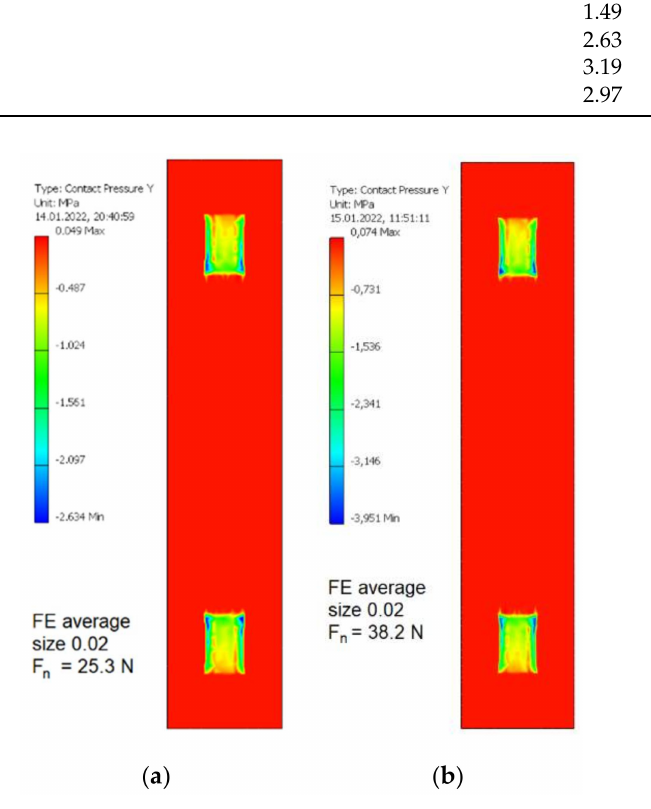
Figure 13. The values of normal contact pressure in two contact zones between eccentric and the segment of swivel arm for the average FE relative size equal to 0.02 and two values of the normal force F n . ( a ) 25.3 N relating to milling with the course cutter ø4; ( b ) 38.2 N relating to milling with the finishing cutter ø5. Table 11. The values of the total indentation depth δ and distance D for the two cutters